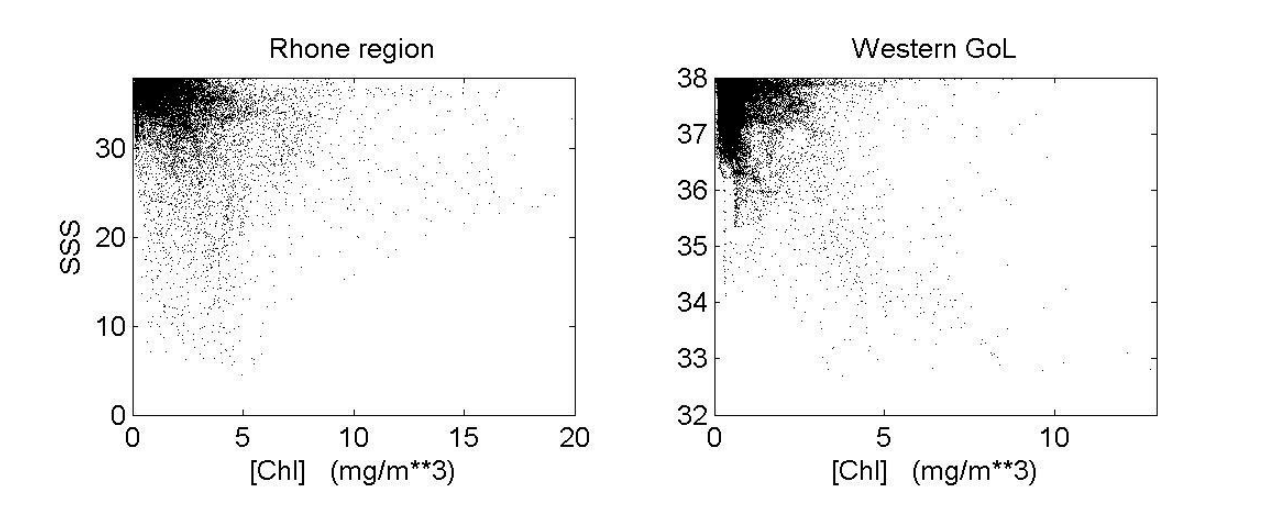
Figure 6. Comparison of MARS surface salinity and SeaWiFS chlorophyll over two limited regions in the GoL. The Rhône region is defined by 4.2°-5.2° in East longitude and 43°-43.5° in North latitude (see Figure 2) and the western GoL region by 3°-4° and 42.5°-43°5. All